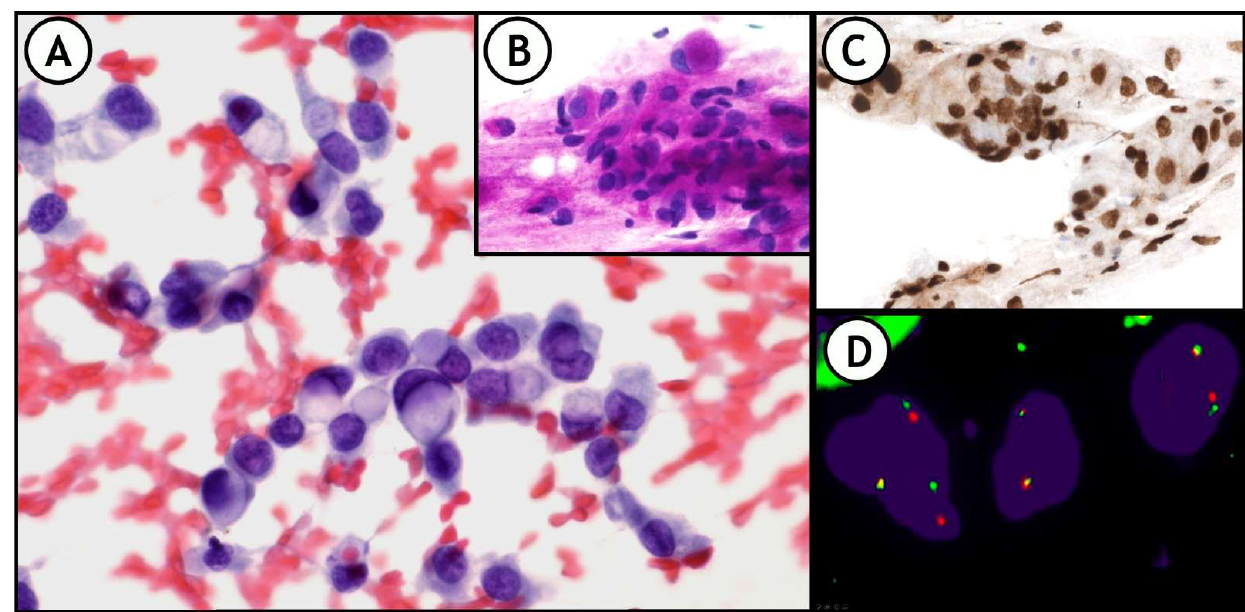
Figure 8. A representative example of the integration of these techniques in daily practice. 36-year-old woman. FNA of right supraclavicular lymph node shows metastasis of signet ring cell adenocarcinoma of lung origin. A : Pap-stained smear; B : PAS stain showing intracytoplasmic PAS positive vacuoles; C : Nuclear positivity for TTF1. D : FISH-ALK demonstrates the presence of the translocation.